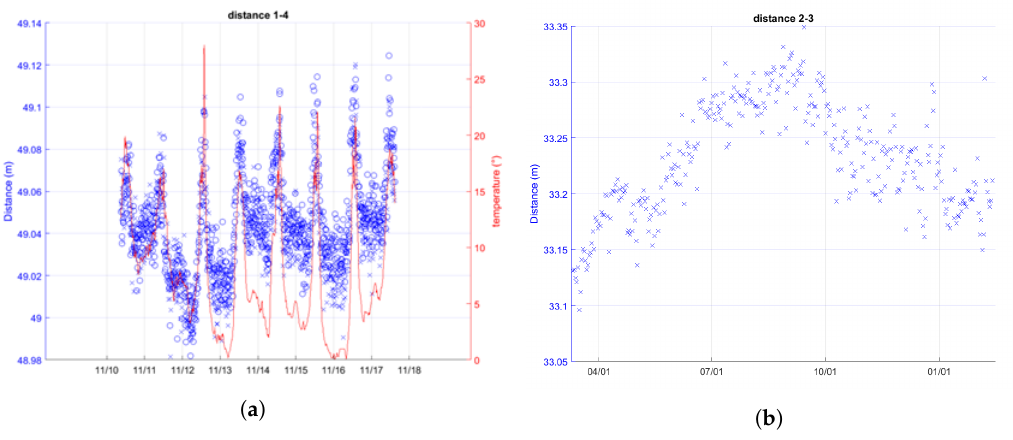
Figure 11. Effect of the temperature on UWB ranging measurements. ( a ) UWB distance measurements between node 1 and 4 (blue) vs. temperature measurements (red). Cluster 1 in Arcetri, from 2016/11/10 to 2016/11/18; ( b ) One-day-averaged UWB ranging measurements between node 2 and 3 over one year (Cluster 1—Roncovetro).